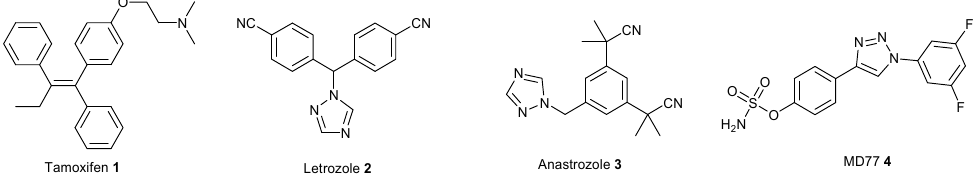
Figure 1. Chemical structures of Tamoxifen 1 , Letrozole 2 , Anastrozole 3 , and MD77 4 .